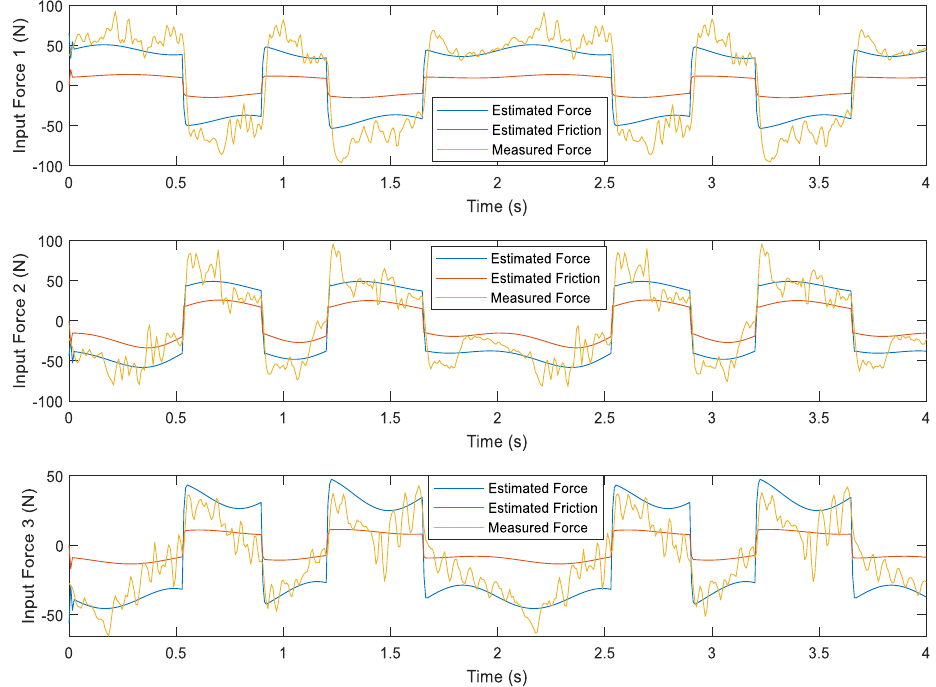
Figure 15. Comparison between the estimated and measured input forces in the validation motion. Appl. Sci. 2020 , 10 , x FOR PEER REVIEW